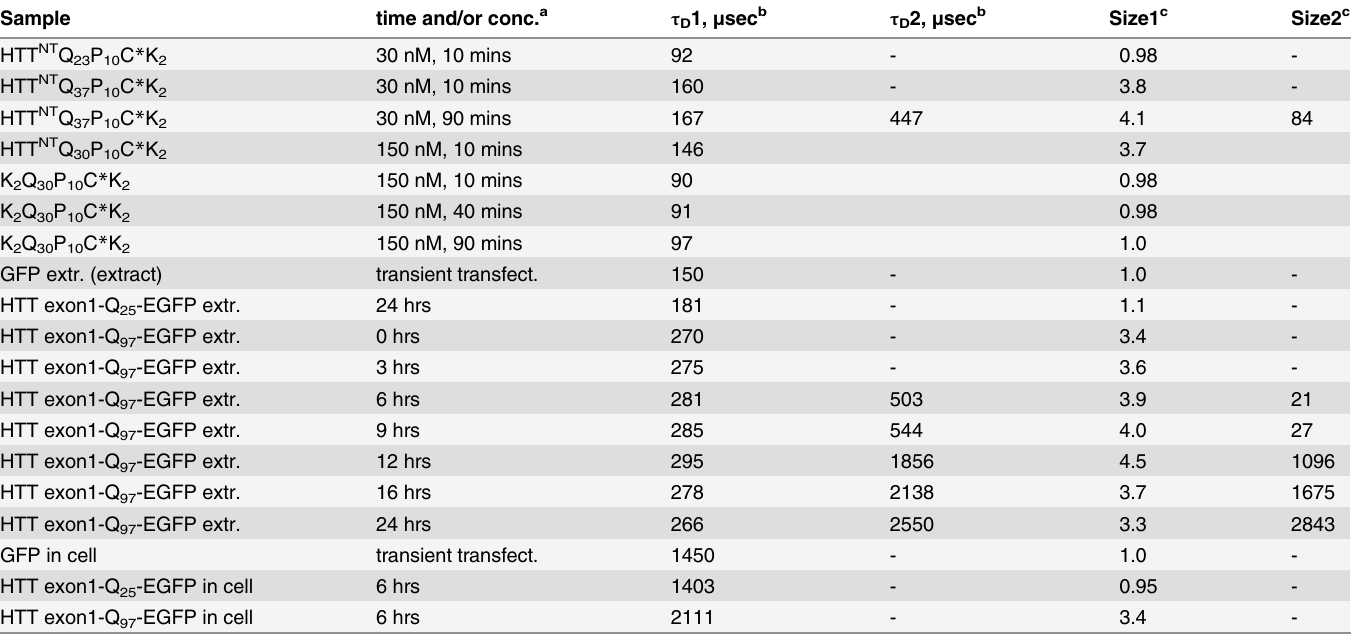
a Cells: post-induction growth times; peptides: concentrations and pre-measurement incubation time. b Diffusion times of species #1 and (if any) species #2. c Number of HTT exon1-like peptides per particle in species #1 and #2.